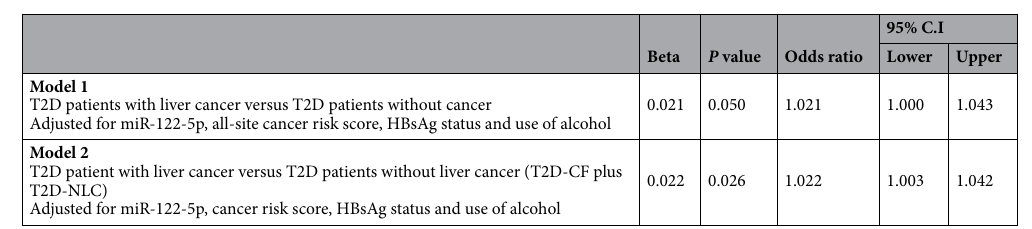
Model 2 T2D patient with liver cancer versus T2D patients without liver cancer (T2D-CF plus T2D-NLC) Adjusted for miR-122-5p, cancer risk score, HBsAg status and use of Table 3. Association of serum miR-455-3p with T2D liver cancer using logistic regression analysis.